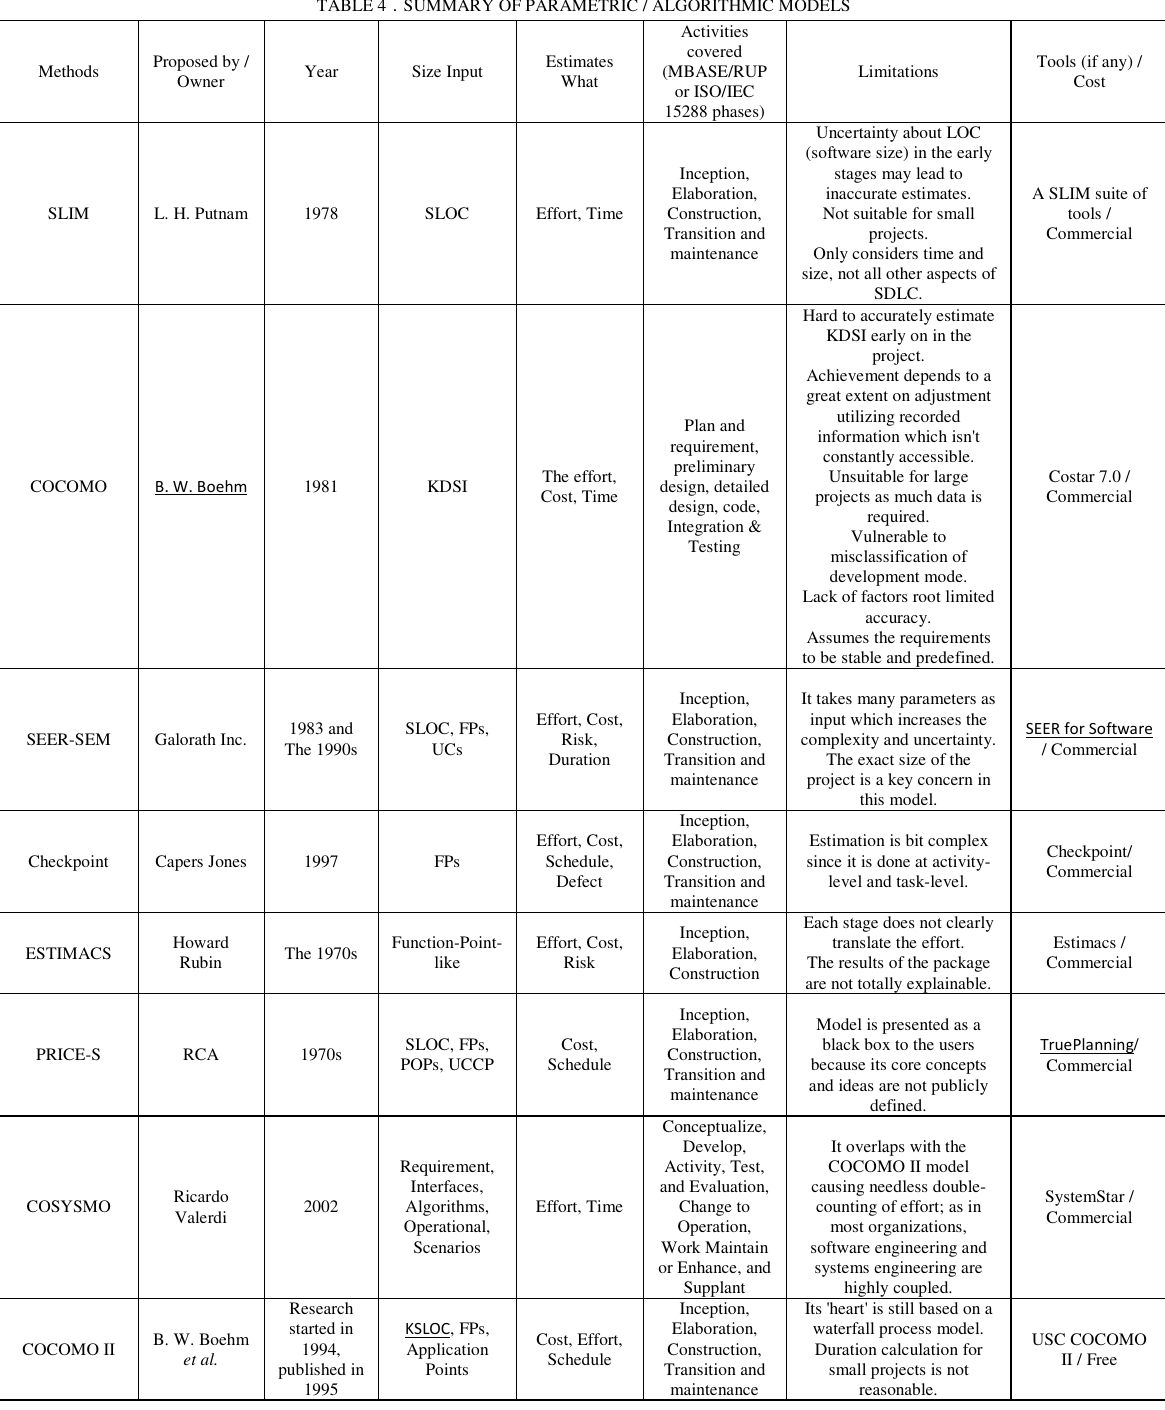
TABLE 4 ． SUMMARY OF PARAMETRIC / ALGORITHMIC